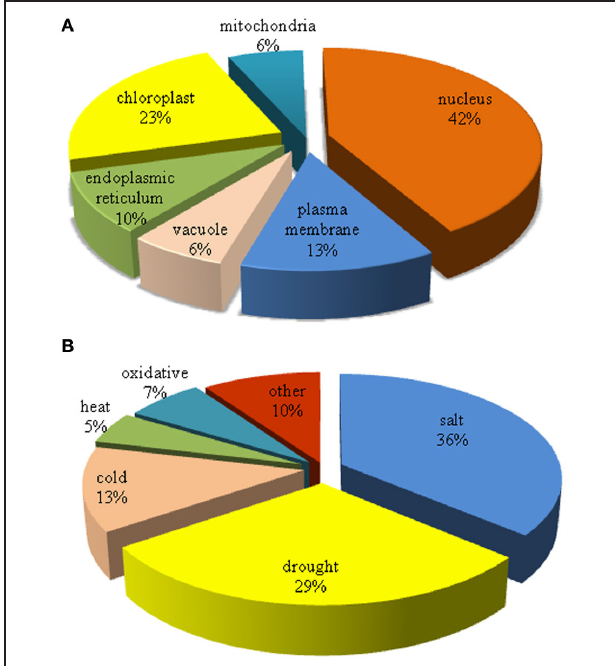
FIGURE 1 | Subcellular localization of overexpressed protein and type of abiotic stress is classified. (A) Percentage of organelles in which overexpressed proteins were localized. (B) Distribution of abiotic stresses in which transgenic plants were